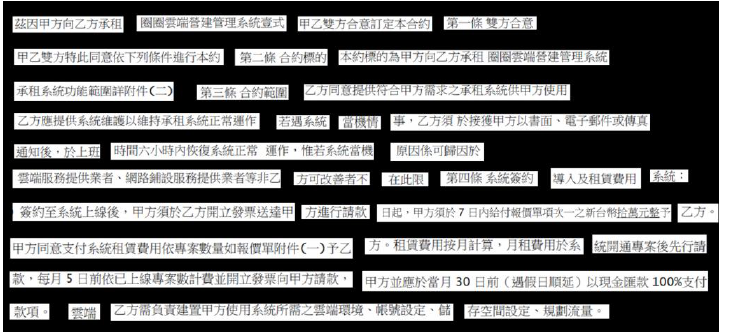
Figure 4. Illustration for segmented text lines (The segmented text highlighting all possible Chinese text and terms for